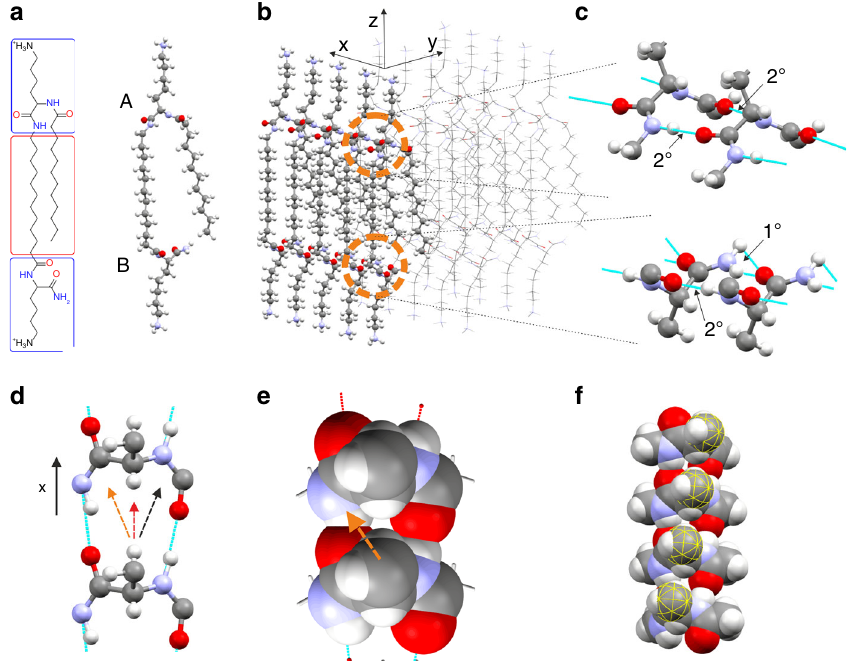
Fig. 2 Dominant chemical interactions and the generation of intrinsic twist: a A Skeletal structural formula (left) and a ball-and-stick model (right) of C 12 - β fi guration. The heads and chains are marked with blue and red respectively. At side A , the head contains two secondary 12 in its bolaamphiphile-like con amines, and at B , one primary and one secondary amine. b Hydrophobic interactions drive the assembly of C 12 - β 12 into a ribbon, with hydrogen bonds forming along the x direction — the ribbons ’ long axis. The domains within the orange circles are magni fi ed in c , illustrating the hydrogen bonds (cyan lines) on sides A (secondary amines (2°)) and B (one secondary and one primary (1°) amines). This asymmetry leads to asymmetry between the two faces of the ribbon (the lysine are truncated in panels c – f , for clarity). d A top view (in the x - y plane) of two ( S ) left-handed head groups (side A ). Close packing of the two heads directs the methylene group into the largest free volume. Right (orange arrow) zero (red arrow) and left (black arrow) optional twists are illustrated. e The same headgroups illustrated with the VdW radiuses. The chirality (in this case the difference in VdW radiuses) leads to a larger free space on the left (orange arrow) than on the right. f The conformation in e induces right-handed intrinsic twist along the x